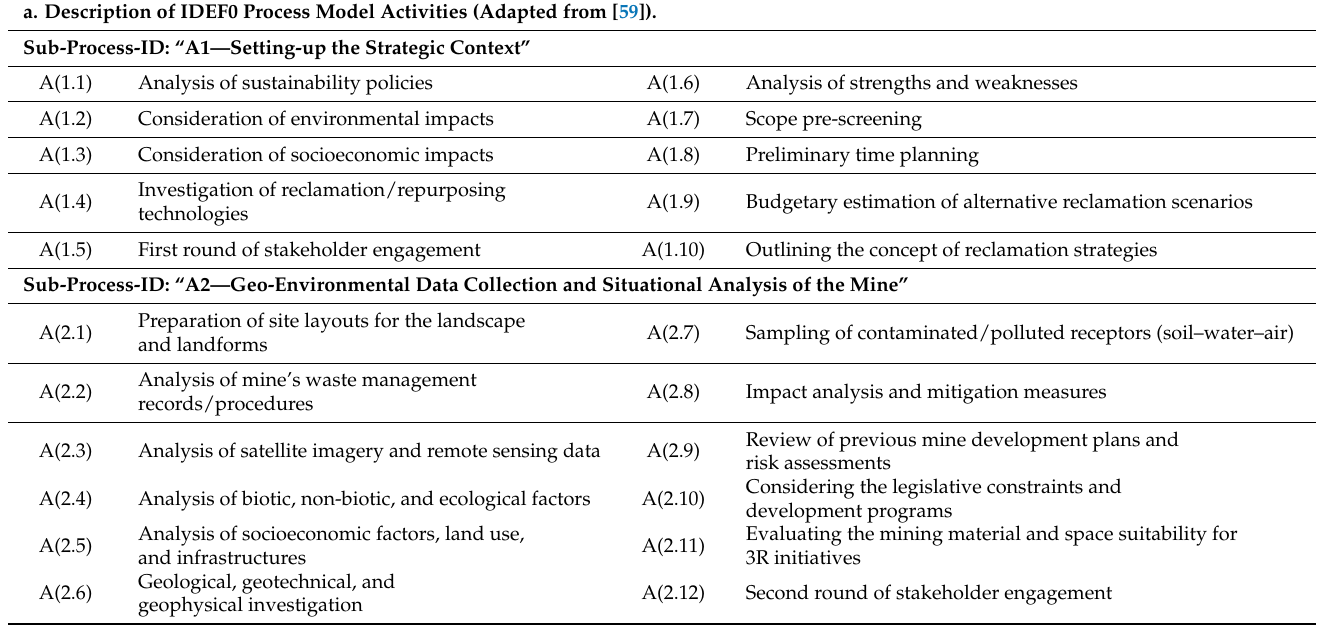
Figure 5. The complete IDEF0 process model. Table 1. a. Description of IDEF0 process model activities (adapted [59]); b. ICOM entities of the IDEF0 process model (adapted from